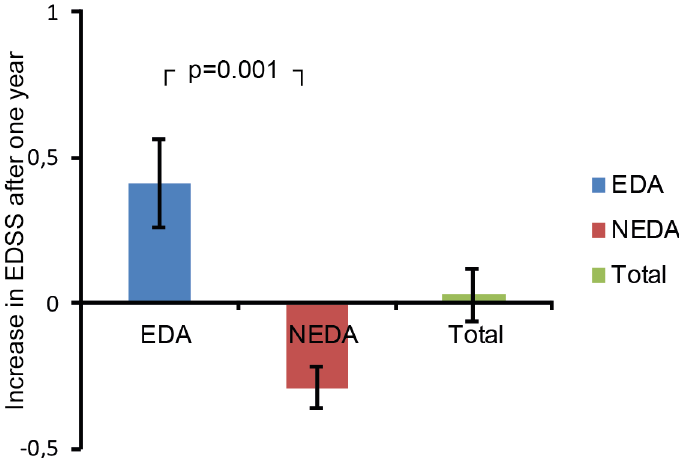
Fig 3. Change in disability after one year. The patient group as a whole had stable disability scores from baseline to follow-up. NEDA patients improved in disability, while the EDA patients showed a disability progression at one-year follow-up.